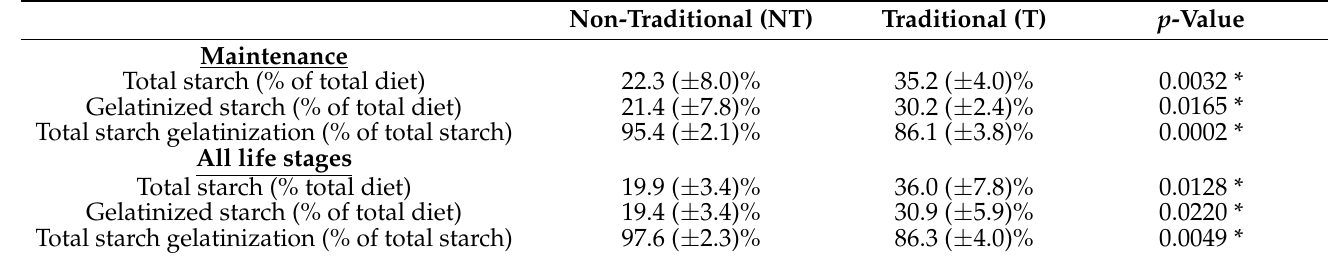
Table 2. Starch content in non-traditional and traditional ingredient diets formulated for maintenance and all life